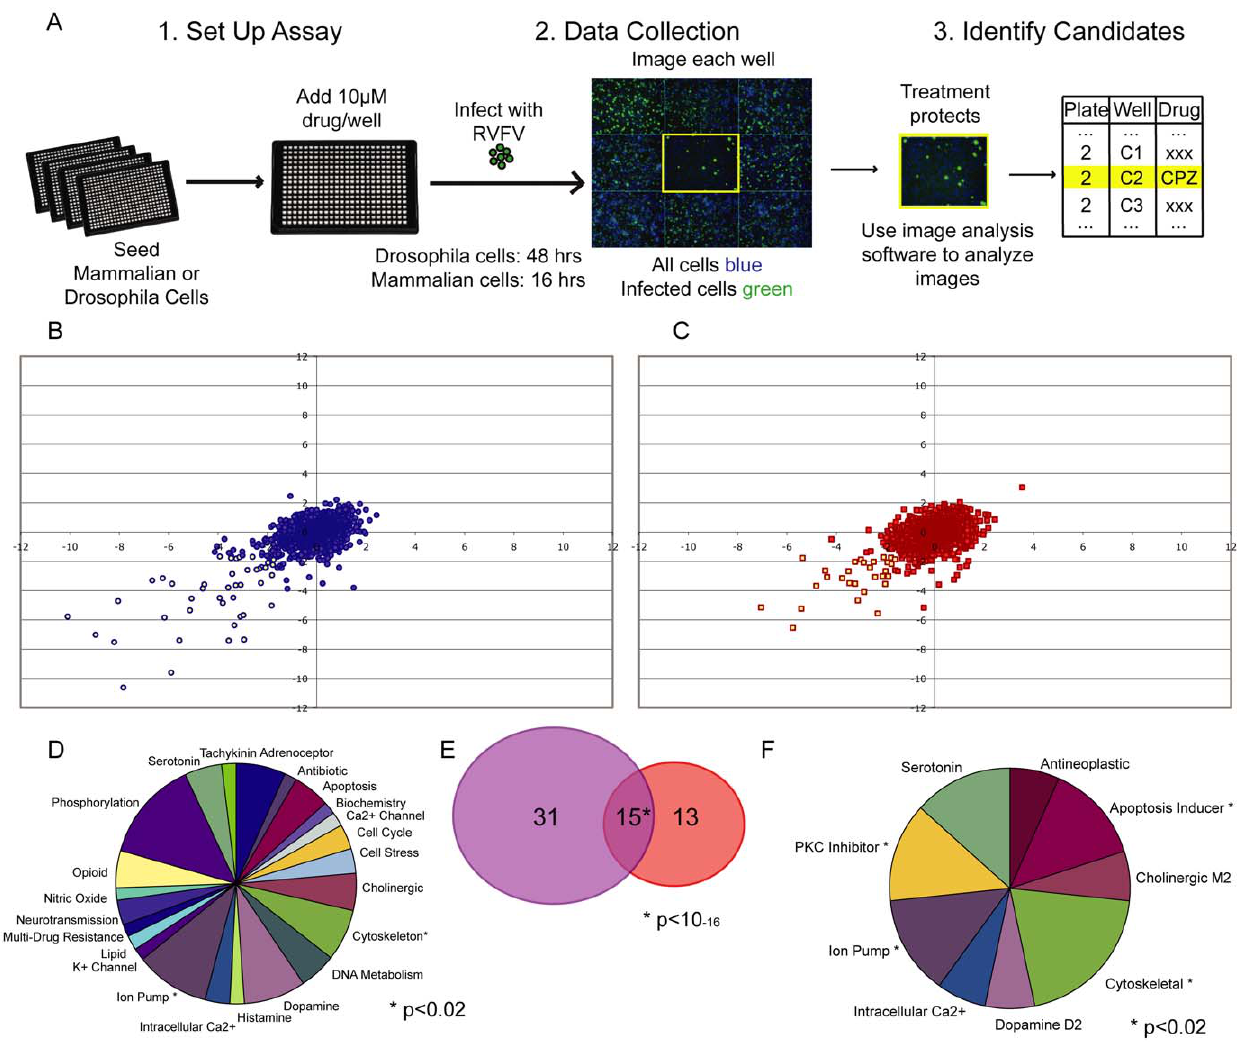
Figure 2. High-throughput screen for inhibitors of RVFV infection. A . Schematic of screening strategy used in human and insect cells. Cells are seeded in 384 well plates, subsequently 10 m M drug was added. The cells were infected with RVFV, then fixed, stained and imaged using automated microscopy. Automated image analysis and statistical thresholds were used to identify inhibitors of RVFV infection. Candidate drugs are then validated and further characterized. B . 6,000 293T cells were plated in 384 well plates, treated with inhibitor and infected at MOI=0.06 for 16 hours. Robust Z scores for infection in mammalian were plotted for each replicate in blue. Each of the four plates is denoted by a different symbol. C . 20,000 S2 cells were plated in 384 well plates, treated with inhibitor and infected at MOI=0.02 for 48 hours. Robust Z scores for infection in mammalian were plotted for each replicate in red. Each of the four plates is denoted by a different symbol. D . Annotated categories of 59 candidate RVFV inhibitors from LOPAC screen. * denotes over-represented groups p , 0.02. E . Venn diagram of the distribution of small molecules: 31 mammalian (blue), 13 insect (red) and 15 pan-inhibitors (purple). * p , 10 2 16 . F . Categories of 15 candidates that block infection of both mammalian and Drosophila cells. * denotes over-represented groups p , 0.02. kinases. We screened in duplicate for each cell type at 10 m M in 0.25% DMSO. The robust Z scores for the percent infection are plotted for all 1280 compounds with the replicates on each axis for human cells (Figure 2B) and Drosophila cells (Figure 2C). Drugs with a Z score of ,2 1.7 in duplicate represent our positive candidates for this screen (p , 0.002) and are in the lower left quadrants of Figure 2B–C.